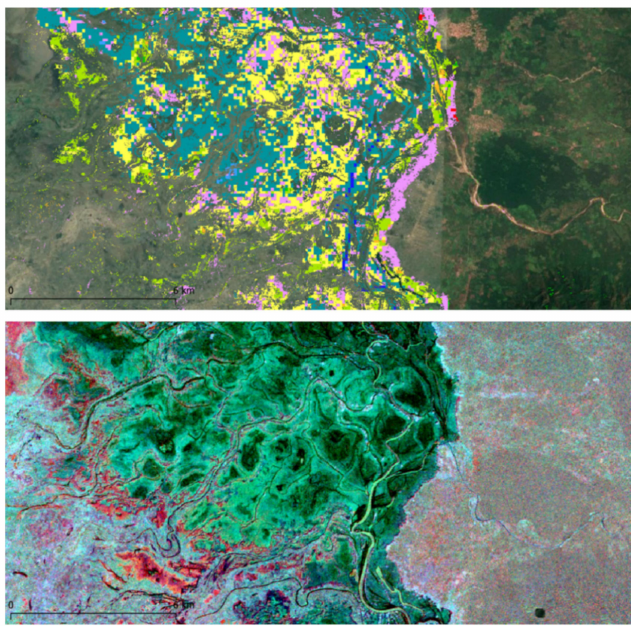
Figure 16. Detail area ( d ) in Figure 10. Top: pixels corresponding to cluster 7, colored according to the underlying CORINE class; background from Google Earth ™ imagery. Bottom: same area, extracted from the RGB change image in Figure